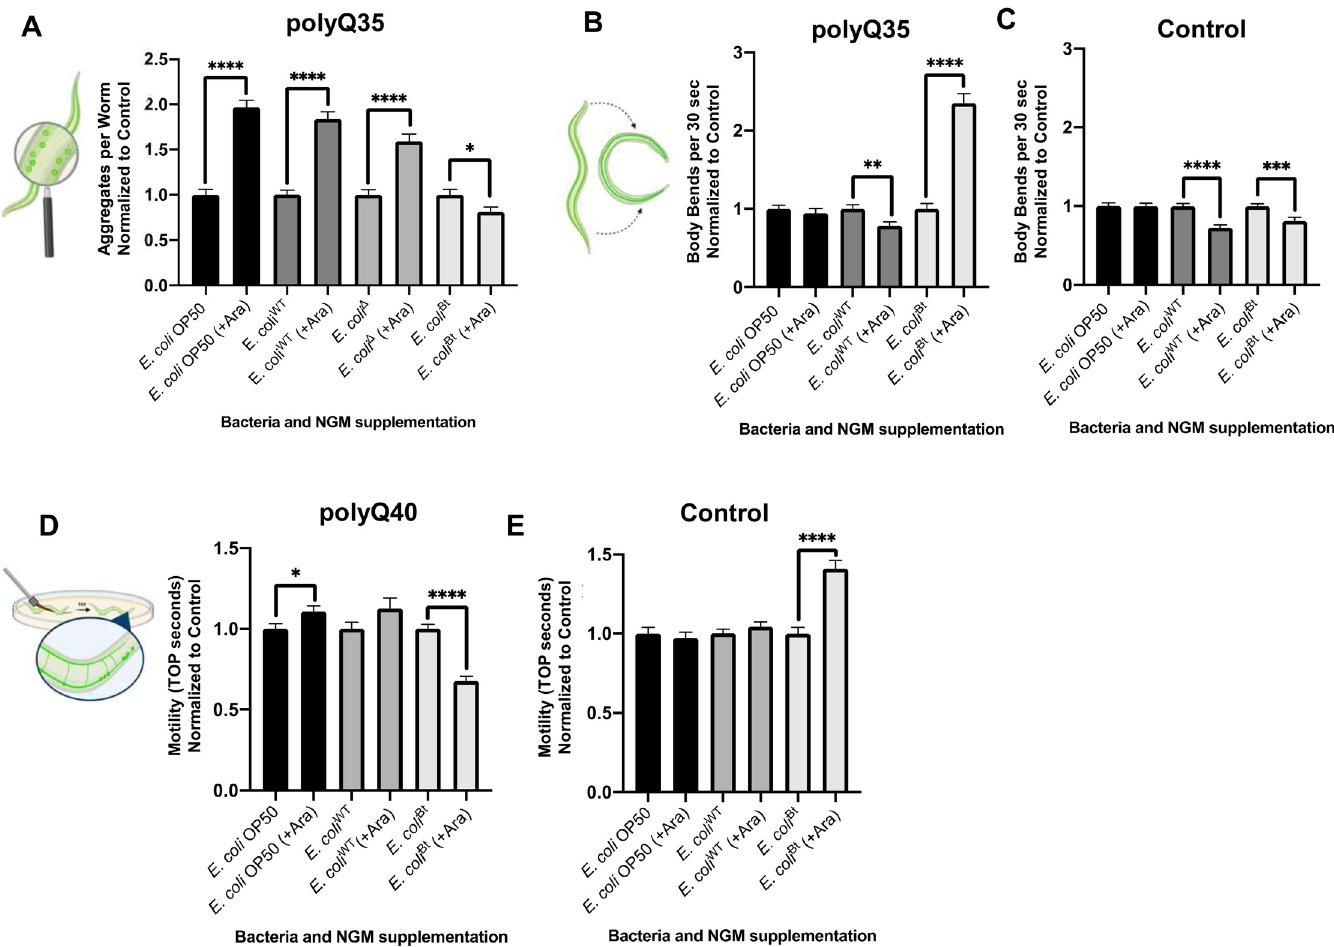
Fig 9. Colonization of the C . elegans intestine with butyrogenic E . coli suppresses aggregation and associated toxicity in distal tissues. A) The effect of butyrogenic bacteria ( E . coli Bt ) on the aggregation profile of worms expressing muscle-specific polyQ35. Data are represented as the average number of aggregates of muscle-specific polyQ35 (AM140) per worm normalized to the control (no arabinose). Animals were fed four different strains of bacteria: non-butyrogenic controls ( E . coli OP50, E . coli WT , E . coli Δ ) and conditional butyrogenic E . coli ( E . coli Bt ). B) The effect of butyrogenic bacteria on the motility of animals expressing muscle-specific polyQ35 and C) control N2 worms. Data are represented as the average number of body bends per worm normalized to control (no arabinose). Each bar is an average of three independent experiments with a total of 45 animals. D) The effect of butyrogenic bacteria on the motility of animals expressing neuronal polyQ40 and on E) control N2 worms. Data are represented as the average TOP seconds per worm normalized to control animals (no arabinose). Error bars represent SEM. Statistical significance between each pair was calculated using Student’s t-test ( � p < 0.05, �� p < 0.01, ��� p < 0.0005 ���� p <